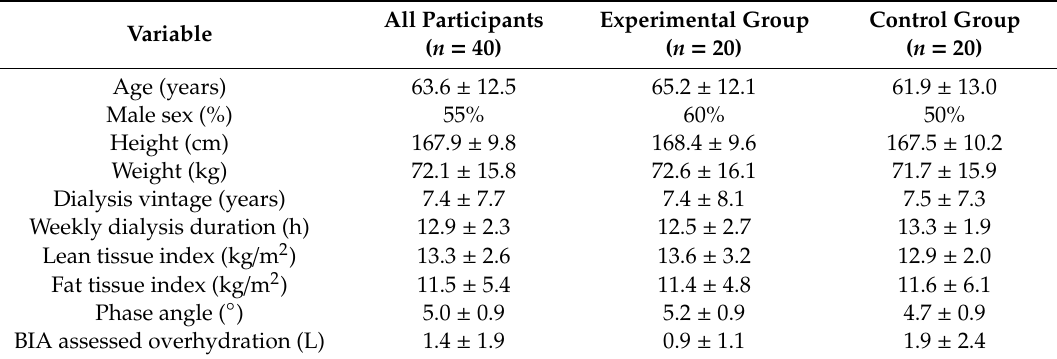
Table 2. Demographic and clinical characteristics.